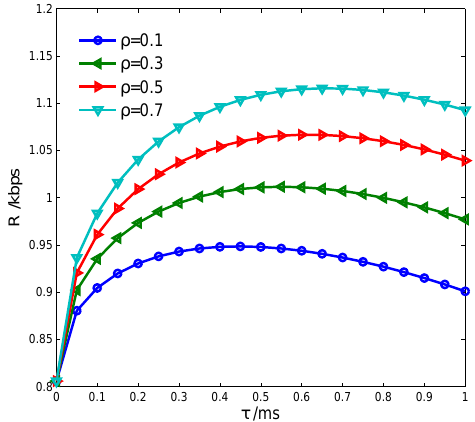
Figure 5. Throughput changed with sensing time.